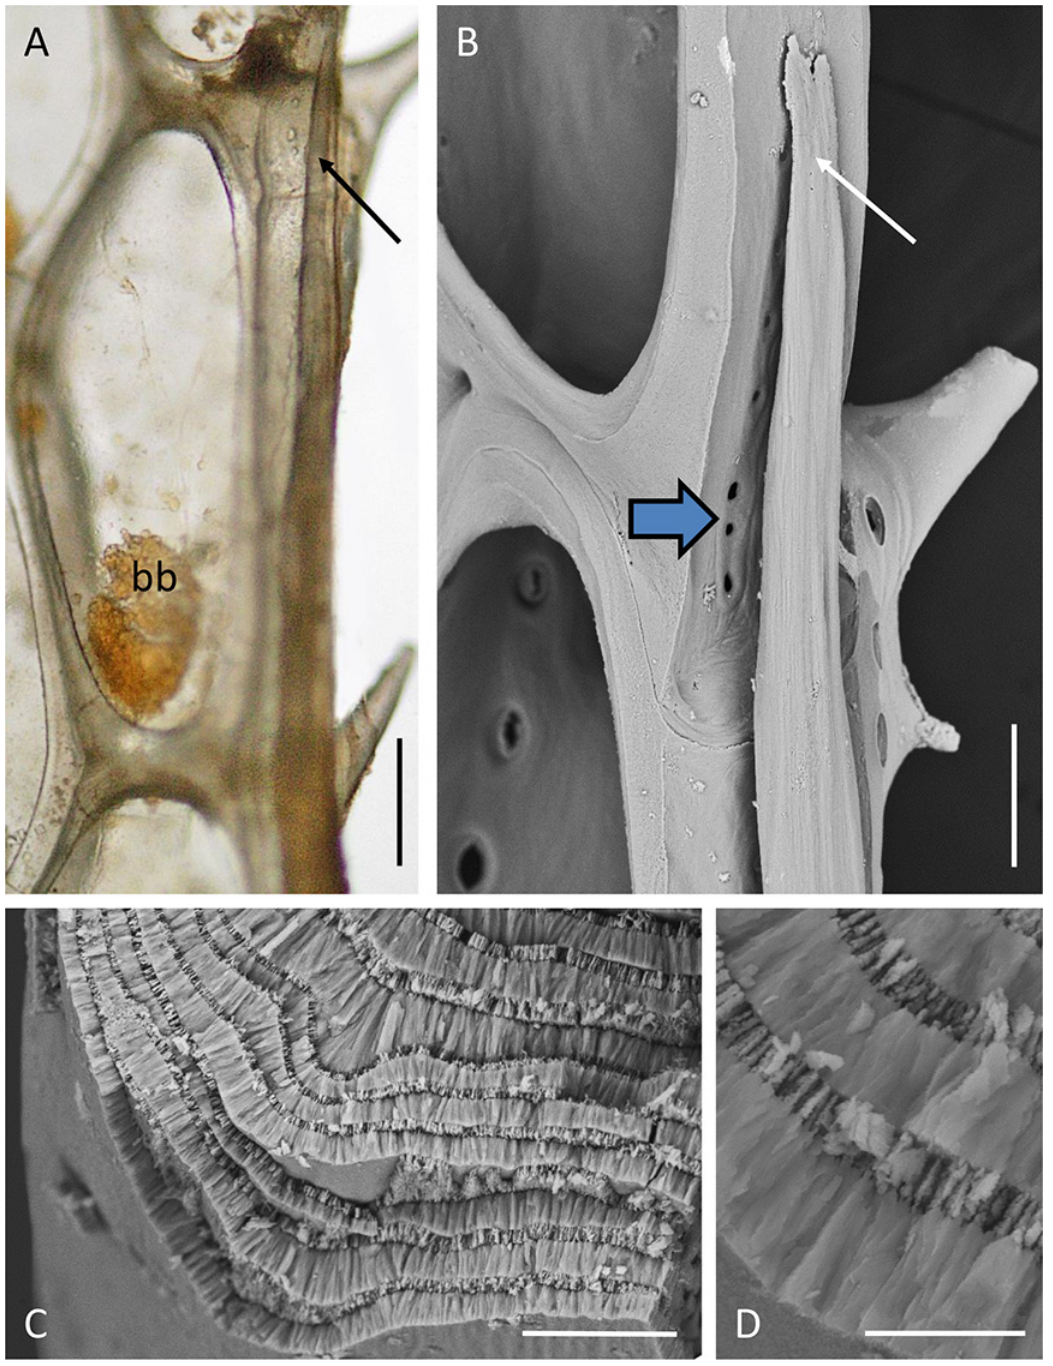
Fig. 9. A . Optical view of the abfrontal side of a distal marginal autozooid (polypide reduced to a residual brown body, bb) adjacent to a lateral kenozooid in which there is a distally tapered (i.e., apically developing) intracoelomic calcareous rod (arrow). B . SEM of a similar view to A but of skeletal elements only, showing the distal tip of the calcareous rod (white arrow) and the communication pores (blue arrowhead) that allow nutrient connectivity between the feeding autozooid and non-feeding kenozooid in which the coelomic cavity comes to be filled by the calcareous rod. C . Fractured transverse section of a calcareous rod showing alternating thick and thin wall-perpendicular prismatic fabric. D . Part of C magnified. Scale bars: A = 200 μm; B = 100 μ m; C = 25 μ m; D = 5 μ